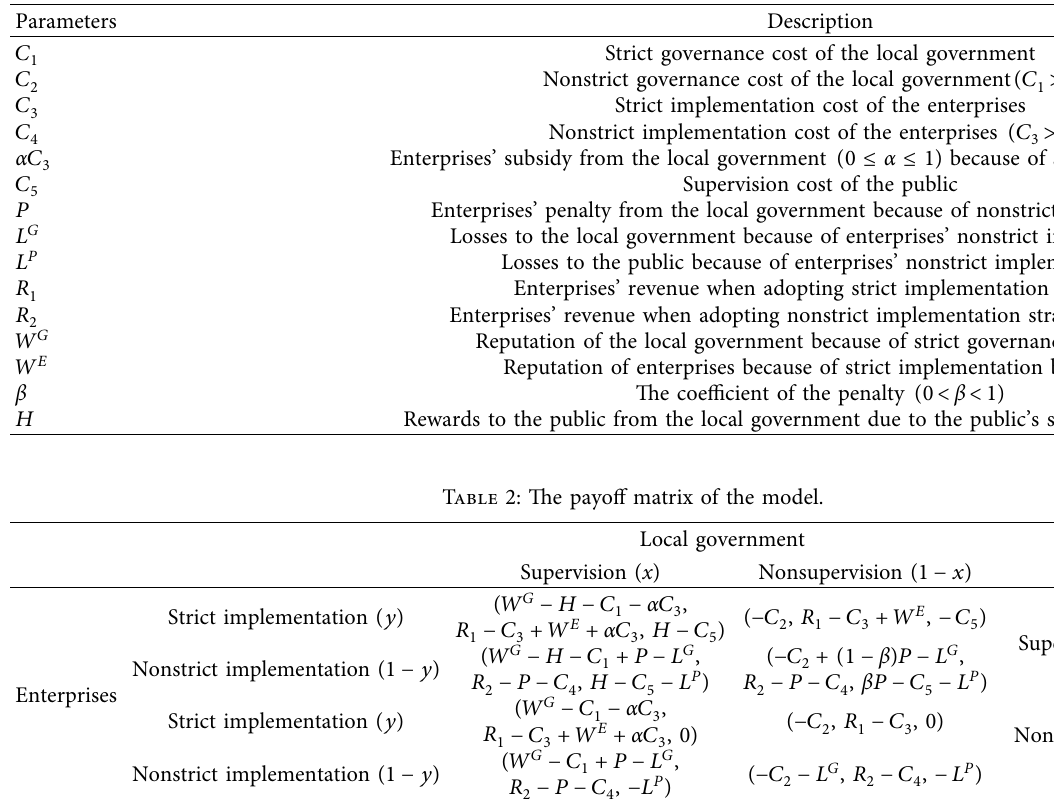
Table 1: Parameters in the tripartite evolutionary game for public health emergencies.